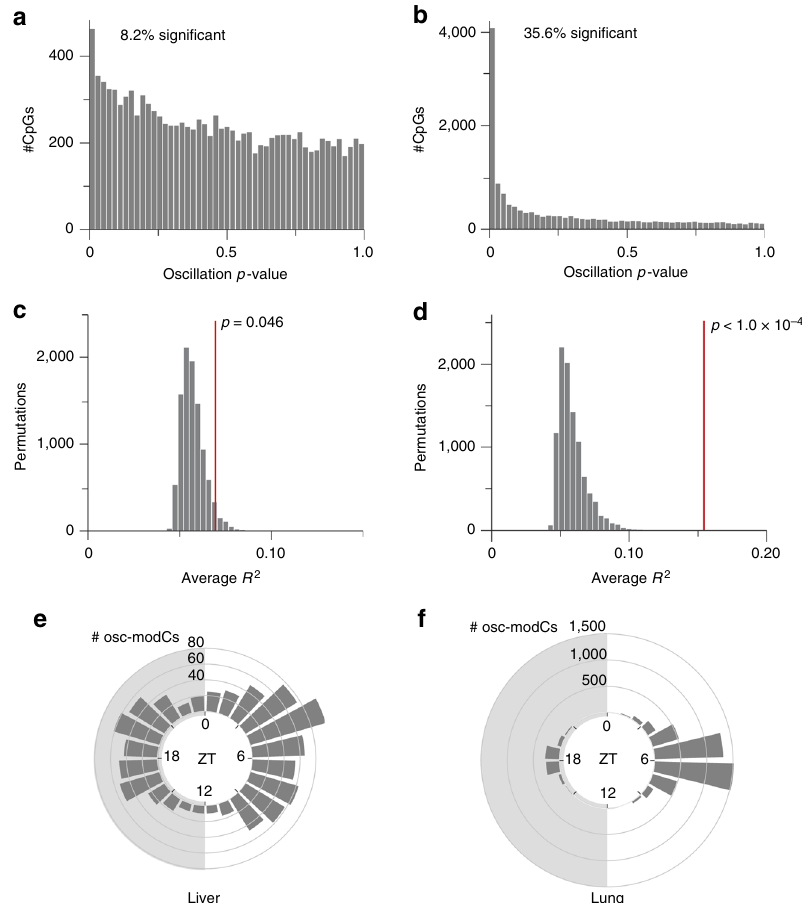
Fig. 4 Characterization of osc-modCs in the 9-mo mouse liver and lung. a , b The p -value histogram of harmonic regression fi ts on individual cytosines showing that 8.2% (983 of 11,941) and 35.6% (5,054 of 14,199) of EVCs were oscillating ( p < 0.05) in a the liver and b the lung, respectively. c , d Average proportion of variance explained ( R 2 ) by the harmonic regression fi ts across all EVCs in each of 10,000 permutations of ZT labels. The red line depicts the observed average R 2 in c the liver and d the lung. e , f Acrophase rose plot showing modi fi cation peak times of osc-modCs in e the liver and in f the lung. osc-modC, oscillating cytosine modi fi